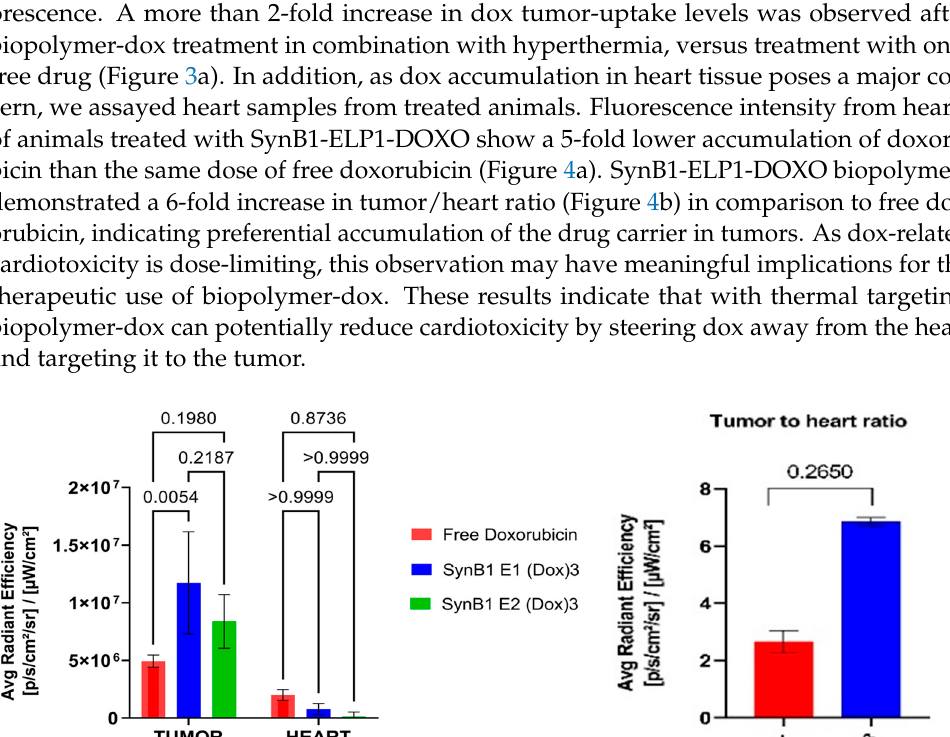
Figure 3. Biodistribution of dox in MDA MB 231 tumor-bearing mice. ( a ) Representative ex vivo fluorescent images of DOX signal accumulated in tumors and organs following intravenous injec- tion of mice with free dox, SynB1-ELP1-DOXO and thermally non-responsive control SynB1-ELP2- DOXO, ( b ) Quantification of dox fluorescent signals in region of interests (ROIs) for tumor and or- gans, 2 h after treatment.